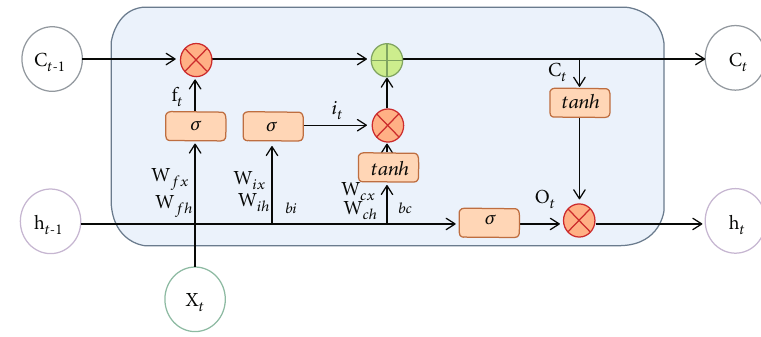
Figure 7: LSTM unit structure diagram.